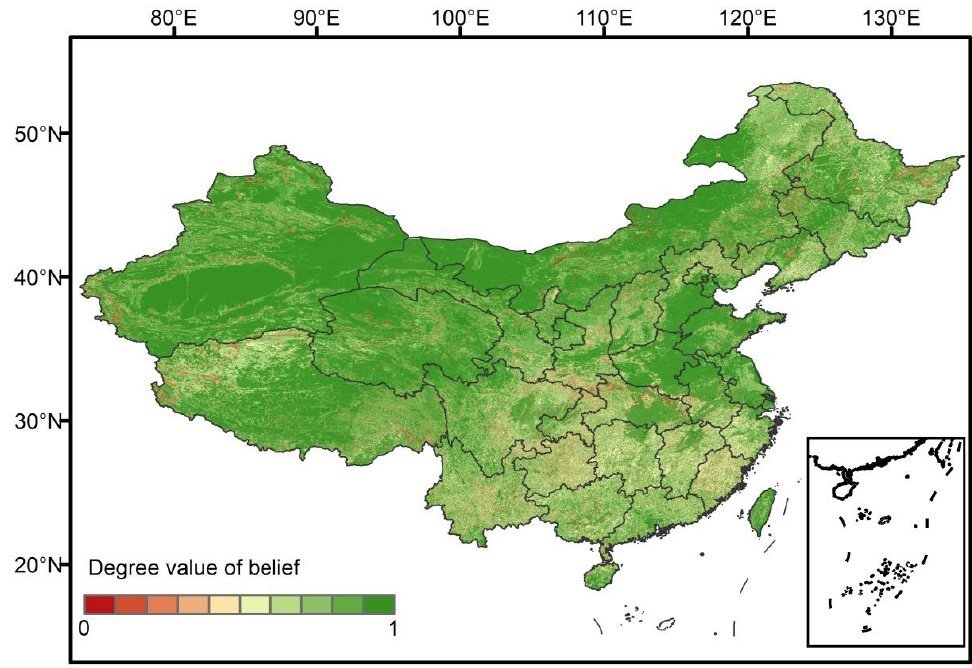
Figure 6. Spatial distribution map of degree value of certainty in 2015.